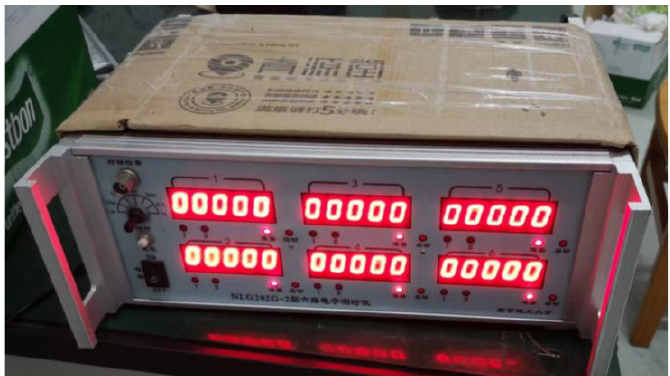
Figure 5. Photograph of the electronic time – measuring instrument.